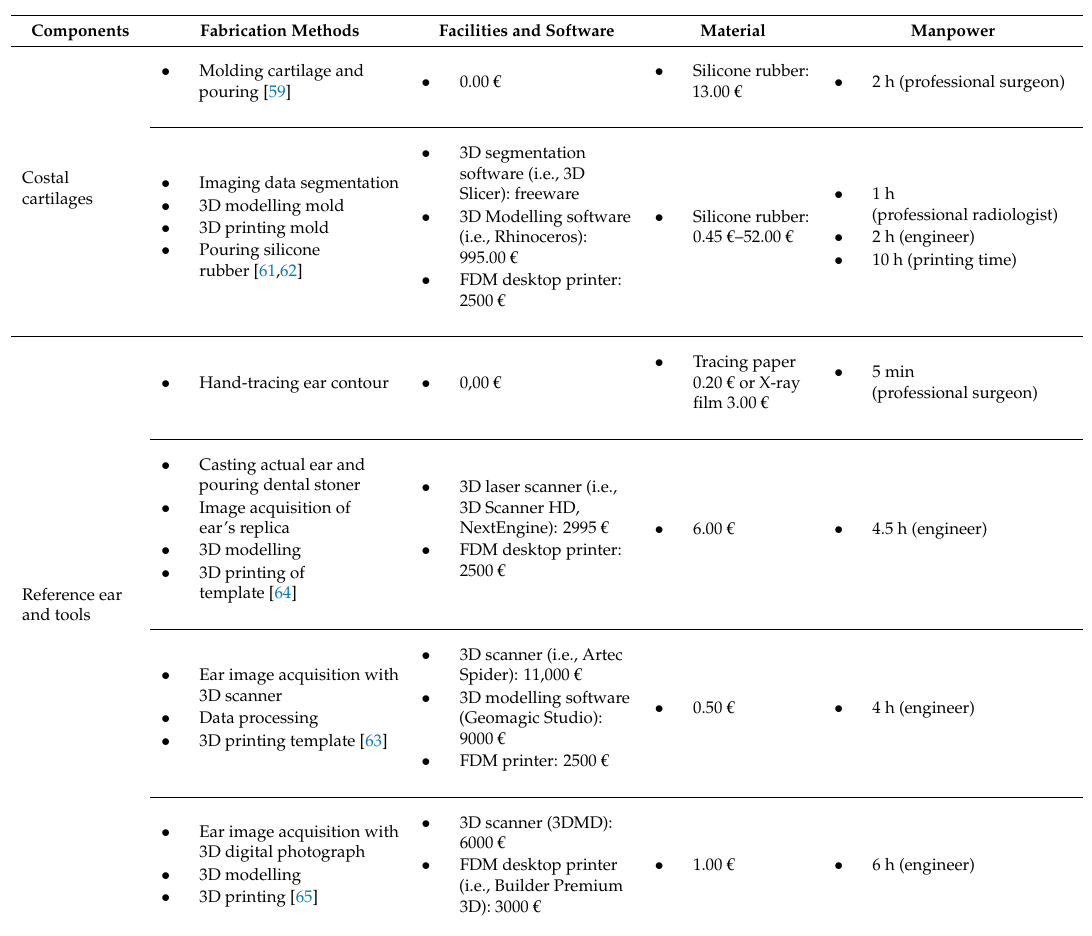
Table 2. Simulator fabrication costs (raw cost and manpower) of each method